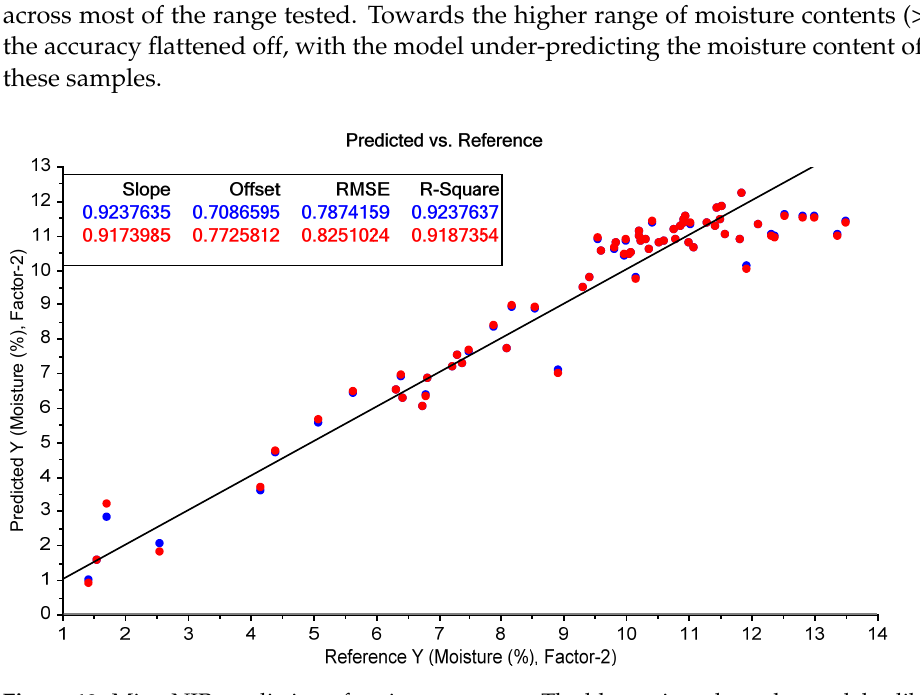
Figure 19. MicroNIR prediction of moisture content. The blue points show the model calibration, while the red points show the model cross-validation.